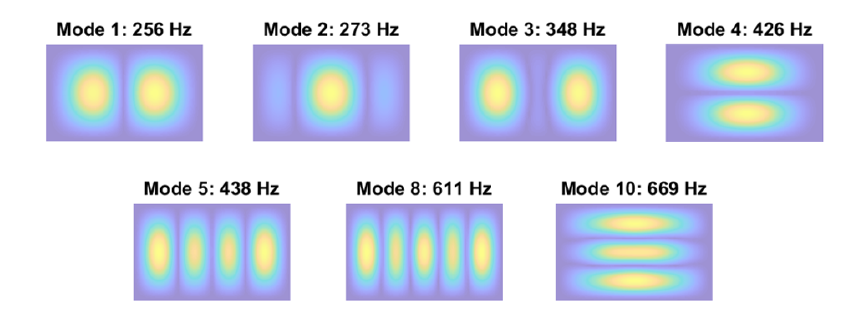
Figure 7. Shapes of the linear modes included in the basis set for the ROM used in this